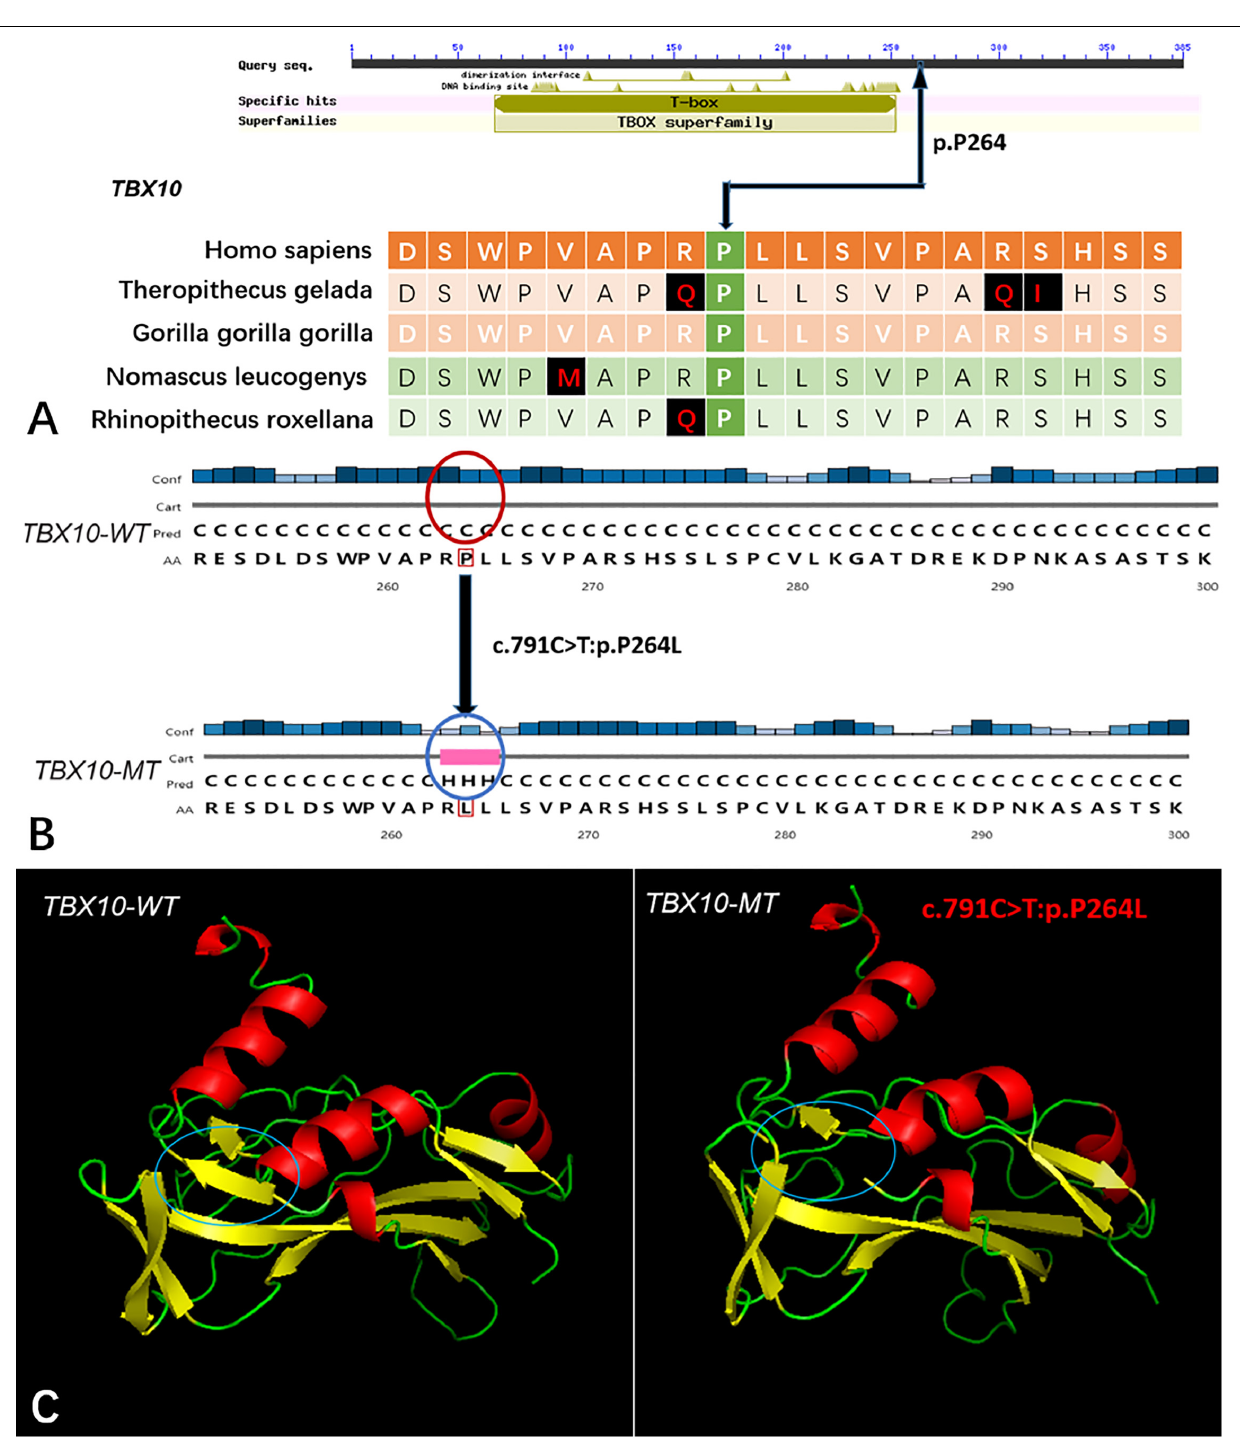
FIGURE 4 | The conservation of TBX10 mutation site in different species, and wild-type and mutated-type secondary and crystal structures. (A) The amino acid affected by the mutation ( TBX10 c.791C > T:p.P264L) was highly conserved among different species; (B) The mutation (TBX10 c.791C > T:p.P264L) was predicted to modify the local secondary structure of the protein, which were circled as red and blue; (C) Template-based modeling of the tertiary structures was carried out. Global view of the crystal structures of wild-type and mutated-type proteins demonstrated the change of protein structure brought by the amino acid substitution. Local homology prediction demonstrated high confidence rate (81.62%). WT means wild-type; MT means